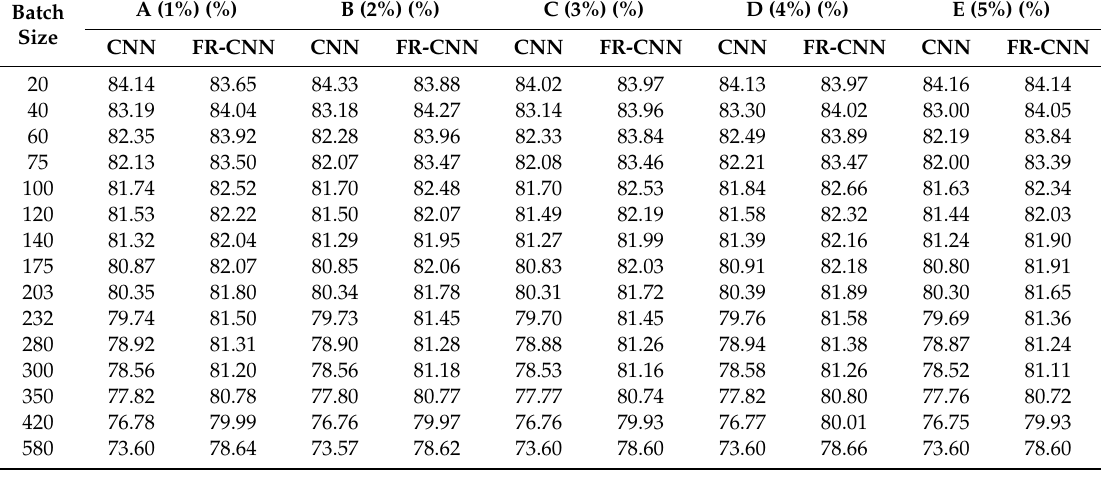
Remote Sens. 2019 , 11 , x FOR PEER REVIEW